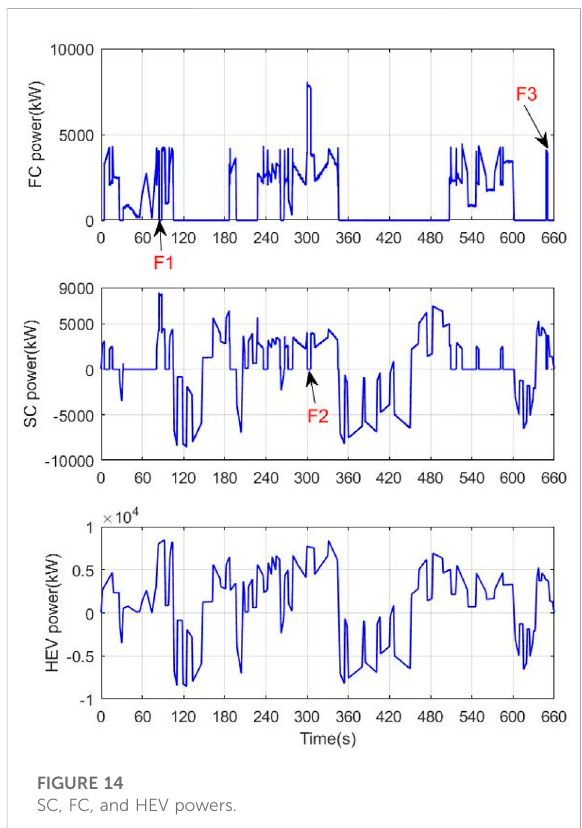
SC, FC, and HEV powers.